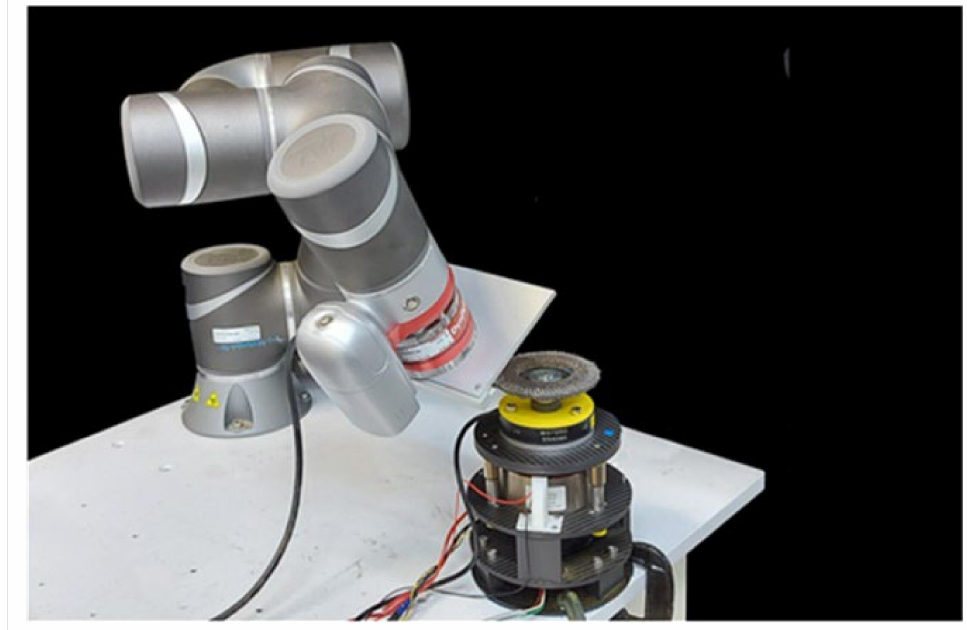
Figure 11. The grinding experimental